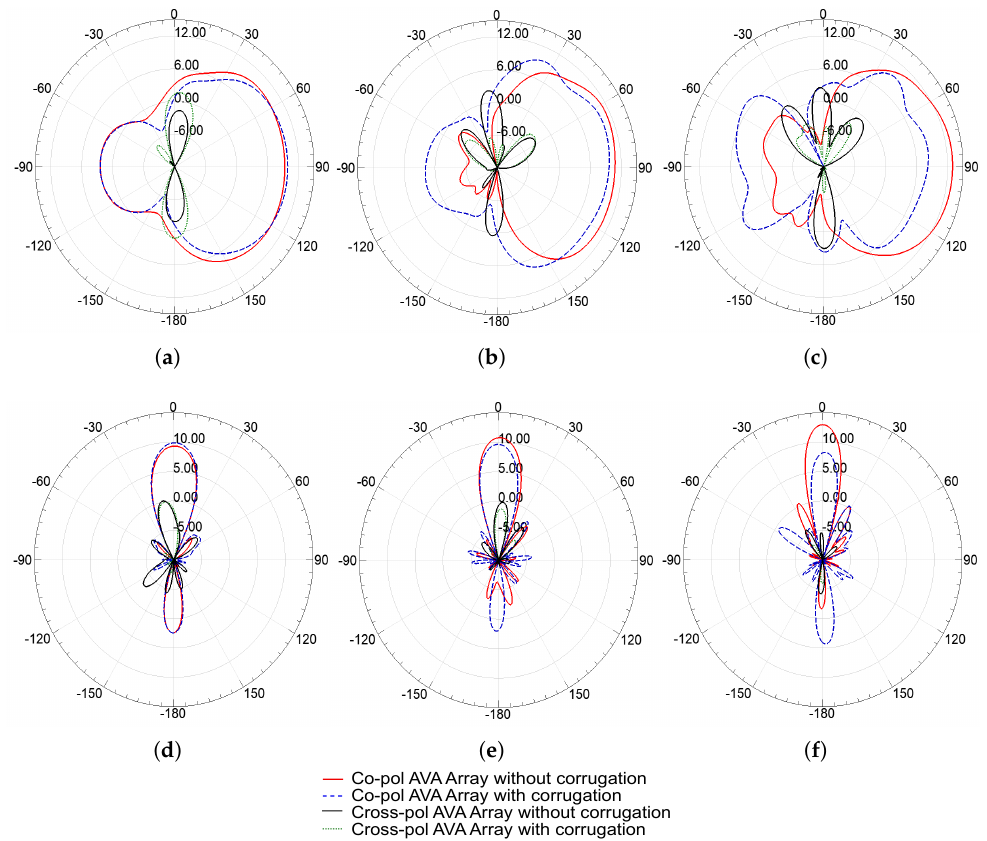
Figure 14. Simulated co-polarization and cross-polarization of E plane ( a – c ) and H plane ( d – f